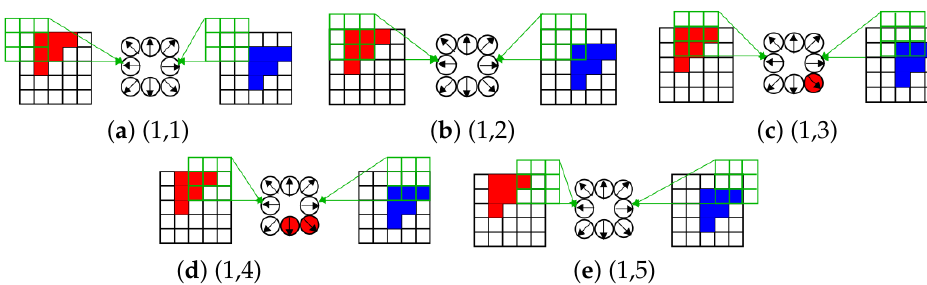
Figure 7. Example of scanning a 5 × 5 receptive field with eight types of LDDN. The subfigure ( a – e ) here represents the scanning process of LDDNs with (1,1) to (1,5) as the center point.The red area represents the object before the movement, and the blue area represents the object after the movement. The LDDN will extract the information of the central pixel and the surrounding pixels from the 3 × 3 area and infer whether to activate the neurons in the corresponding direction. As shown in ( a ), none of the LDDN have been activated when the location of central pixel is (1,1); however, the LDDN corresponding to the rightward and the downward are activated when the location of central pixel is (1,2), as shown in ( b